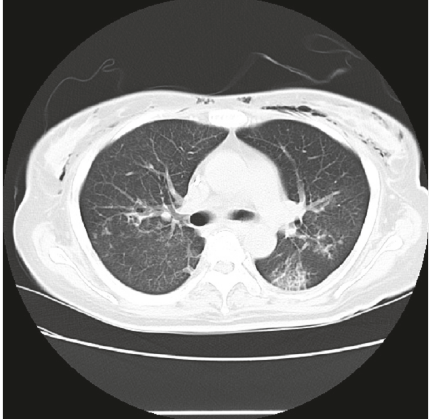
Figure 3: CT scan after extubation. The pulmonary infiltrates and ground-glass opacities had